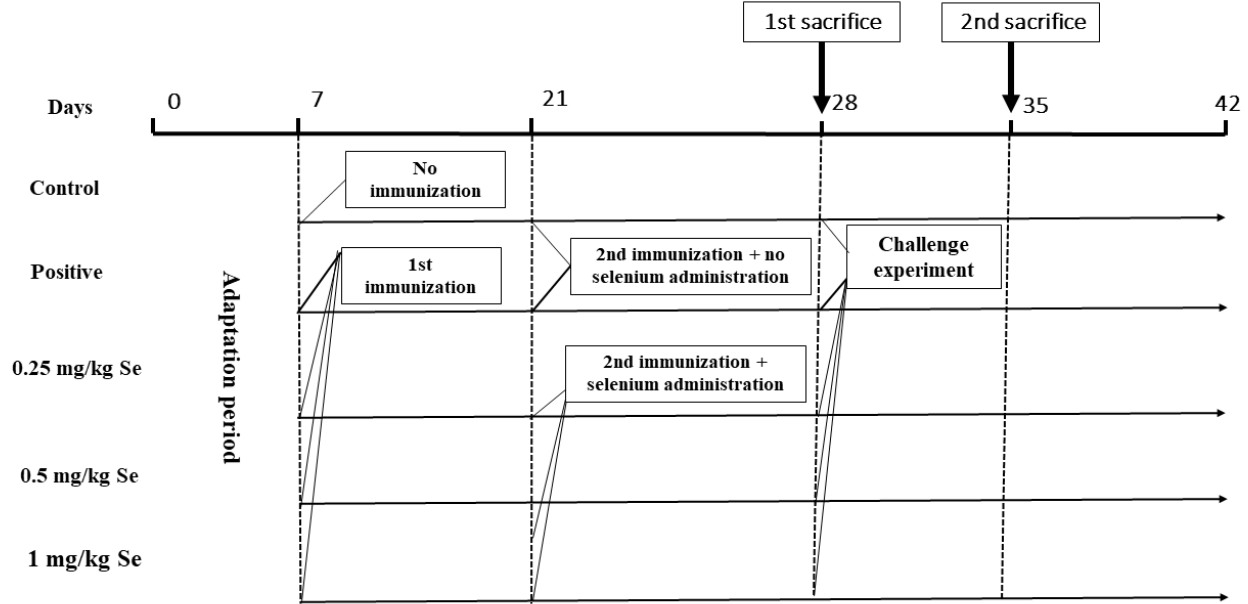
Figure 11. Experimental design. Control, normal group, positive, mice received H9N2 AIV vaccine + 0.5 mL of 0.9% normal saline once every 2 days in 14 days; 0.25 mg/kg, mice received H9N2 AIV vaccine + 0.5 mL of 0.25 mg/kg selenium solution once every 2 days in 14 days; 0.5 mg/kg, mice received H9N2 AIV vaccine + 0.5 mL of 0.5 mg/kg selenium solution once every 2 days in 14 days; 1 mg/kg, mice received H9N2 AIV vaccine + 0.5 mL of 1 mg/kg selenium solution once every 2 days